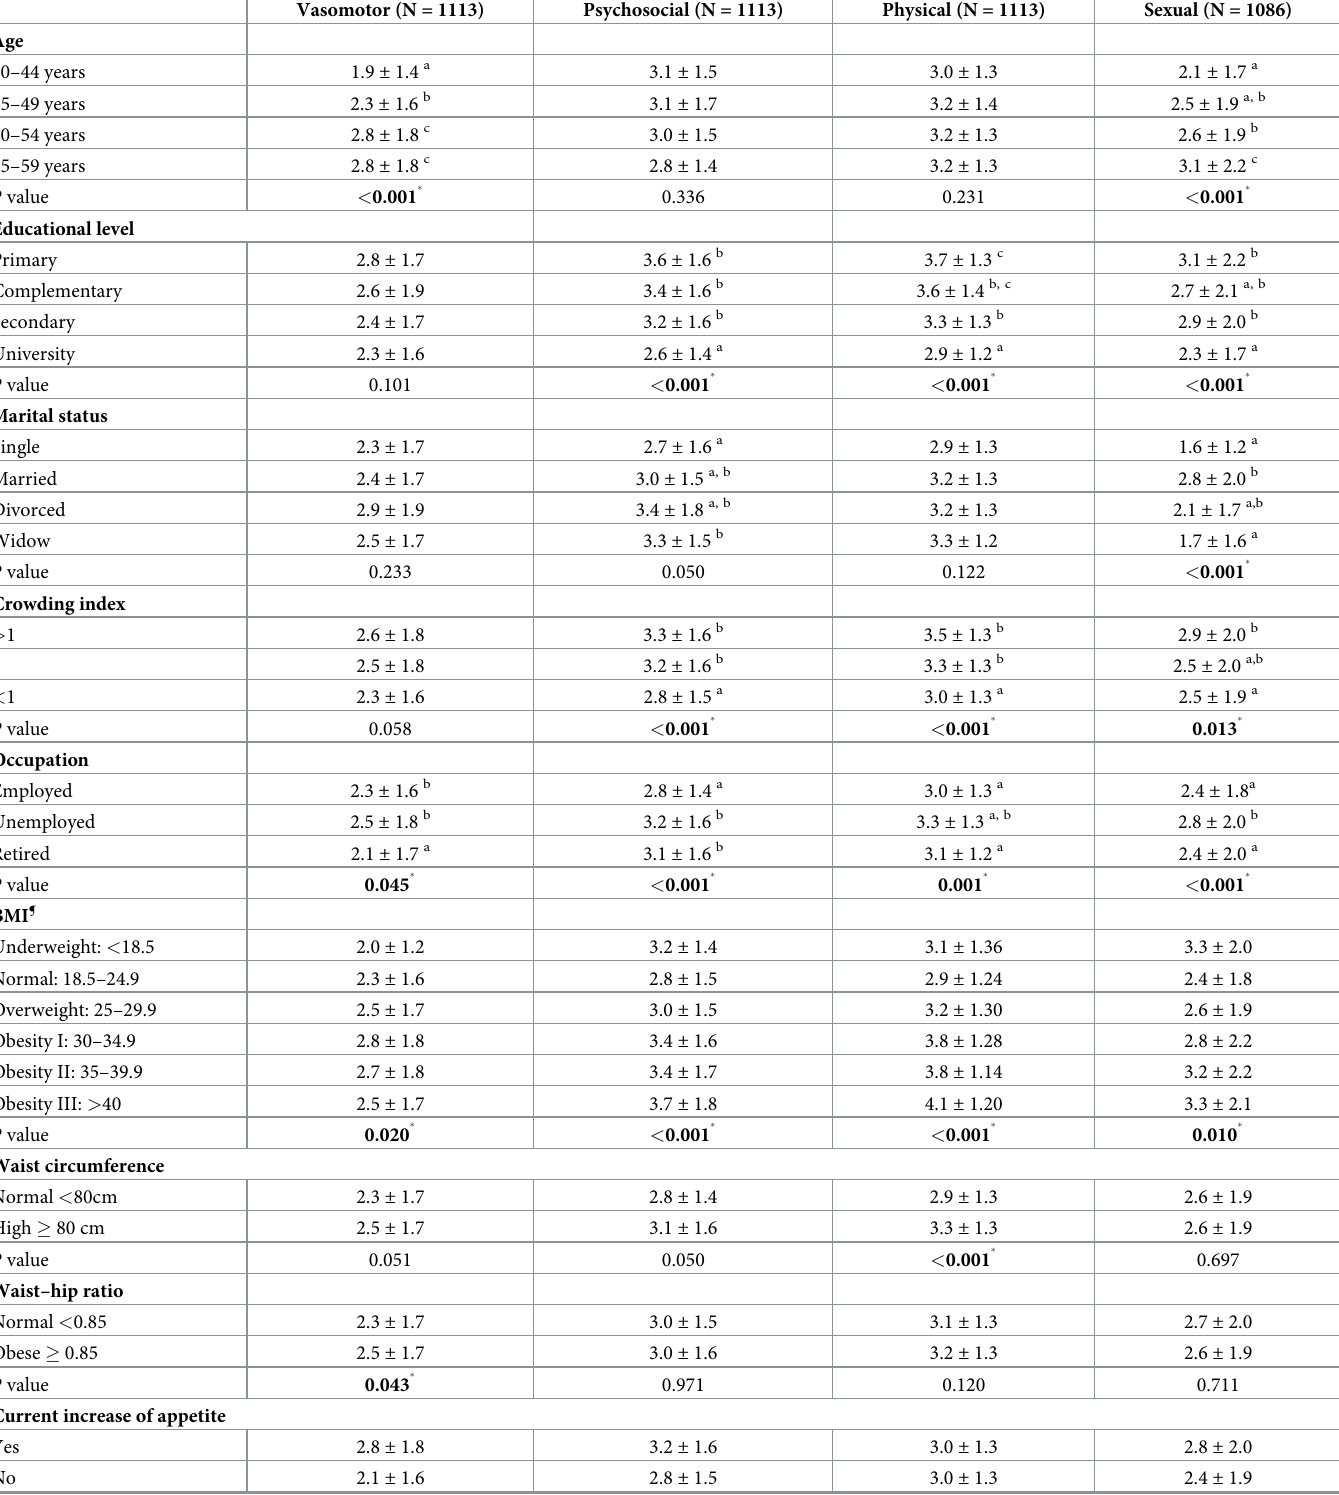
Table 3. Mean scores of MENQOL subdomains according to sociodemographic, anthropometric and lifestyle